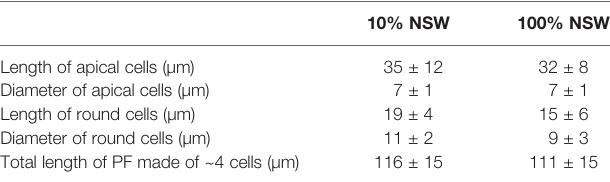
TABLE 1 | Size parameters of cells and fi laments of E. subulatus cultivated in seawater featuring distinct